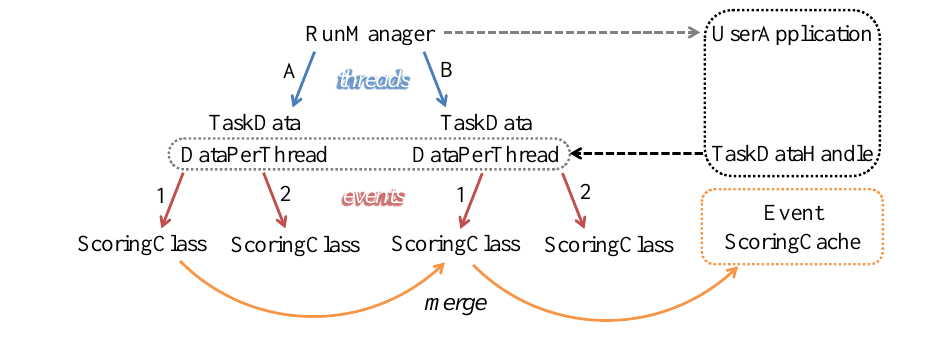
Figure 3. A schematic diagram that shows the process of aggregating scoring data in G eant V.